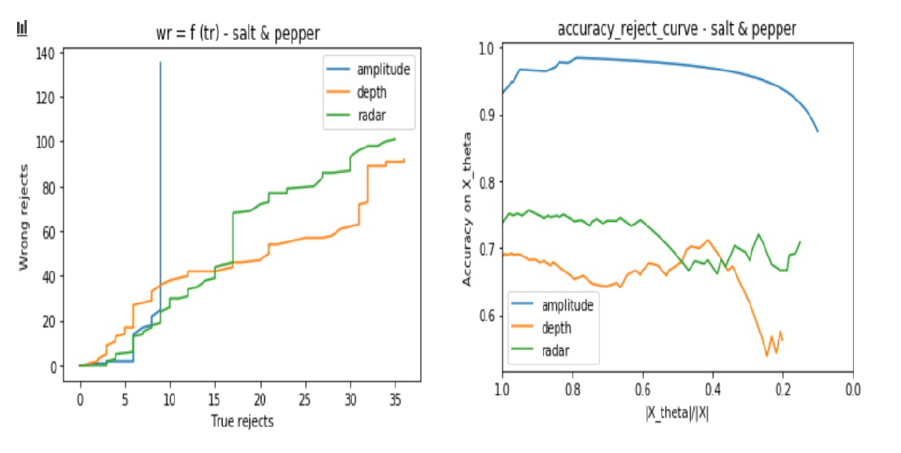
Figure 14. Three classifiers behavior evaluation curves when performing classification with reject option on noisy data sets—considering Poisson noise.